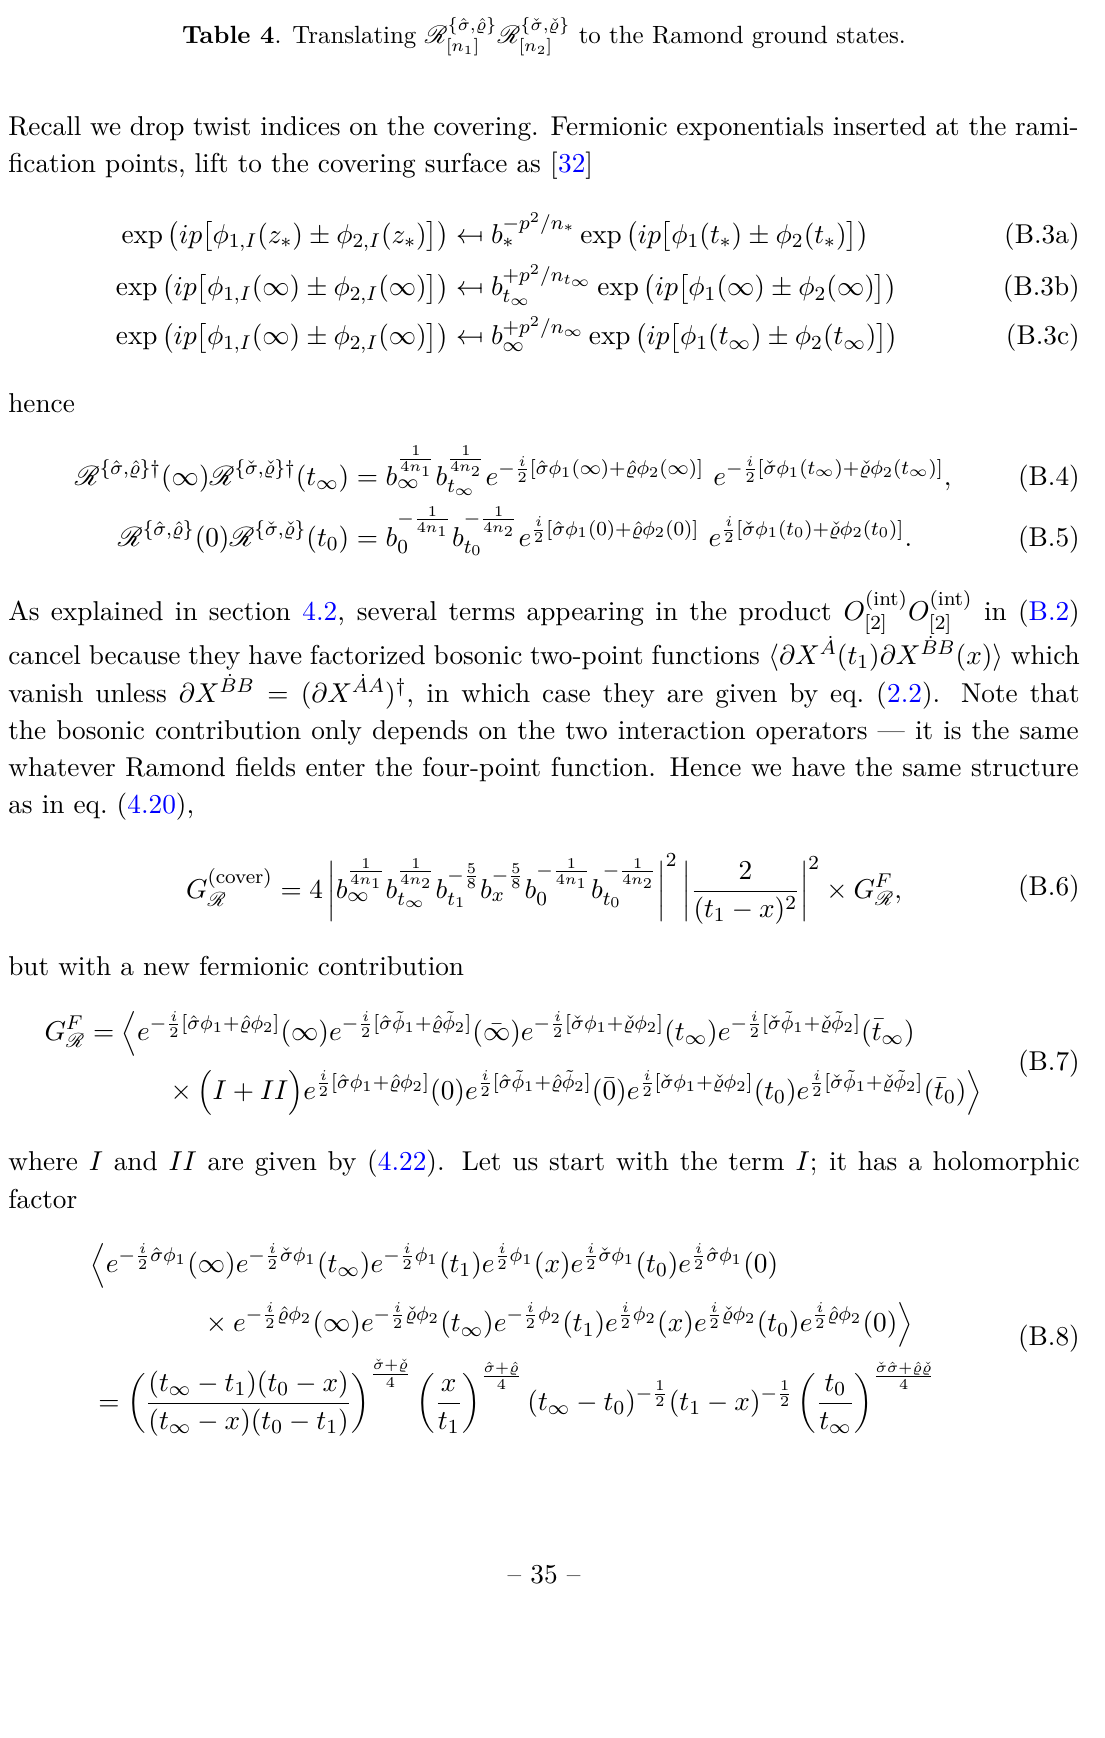
Table 4 . Translating R { ˆ σ, ˆ % }